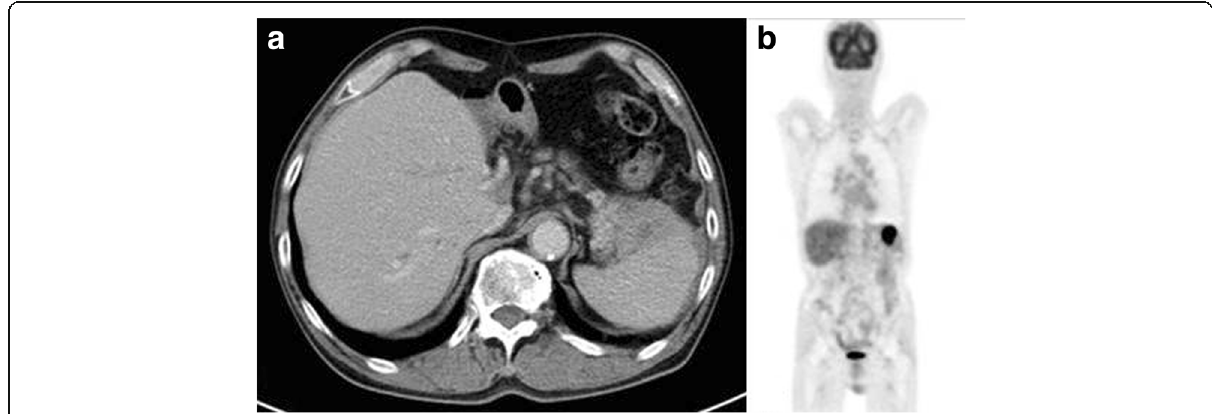
Fig. 5 Preoperative image findings. a Preoperative computerized tomography and b fluorodeoxyglucose positron emission tomography